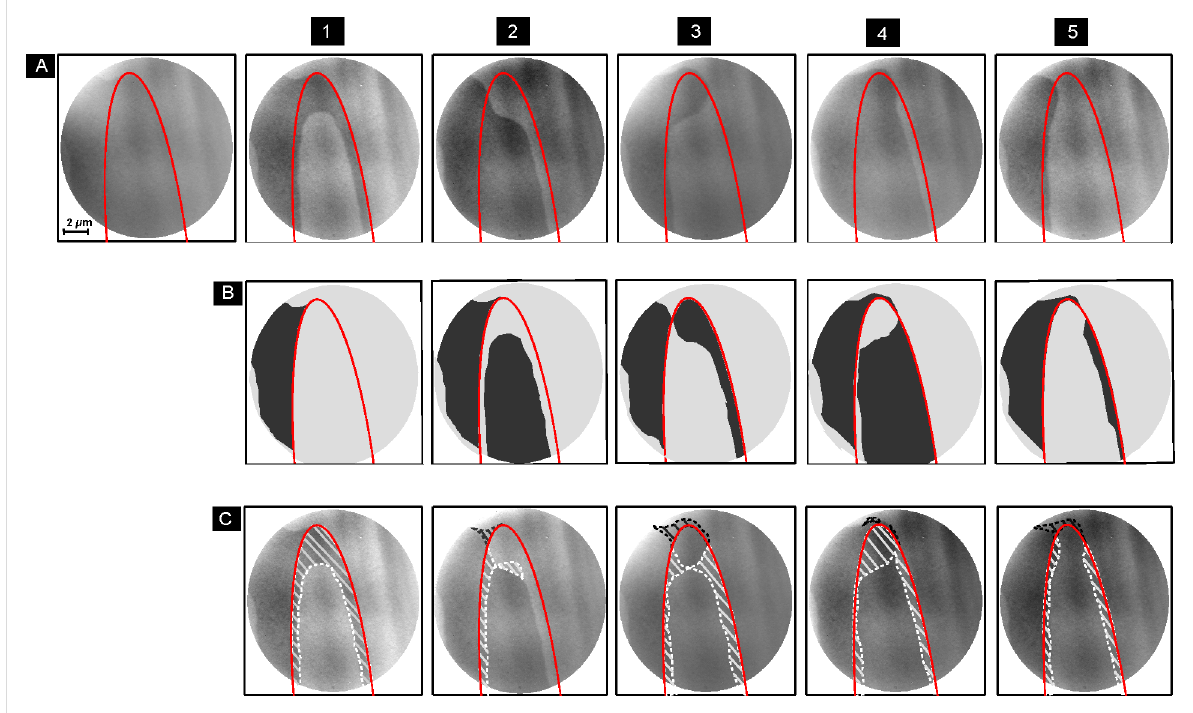
Figure 2: Static XMCD-PEEM images acquired at room temperature, each image after one single laser pulse of 800 nm wavelength and fluence 4.9 mJ/cm 2 in the center. Dark and light gray contrast corresponds to opposite magnetization directions. Row A presents a sequence of images with one single laser pulse in between each image. The red ellipse marks a line of constant fluence of 3.5 mJ/cm 2 . Row B presents synthetic images indi- cating what would be expected if the toggle switching was deterministic inside the red ellipse. Row C shows the difference between the actual experi- ment and such a deterministic toggle switching with threshold of 3.5 mJ/cm 2 . The white hatched areas indicate regions inside the ellipse that should have switched but did not switch, while the black hatched areas outside the ellipse mark regions of the sample that should not have switched but did switch. The numbers on top of each column count the laser pulses on the